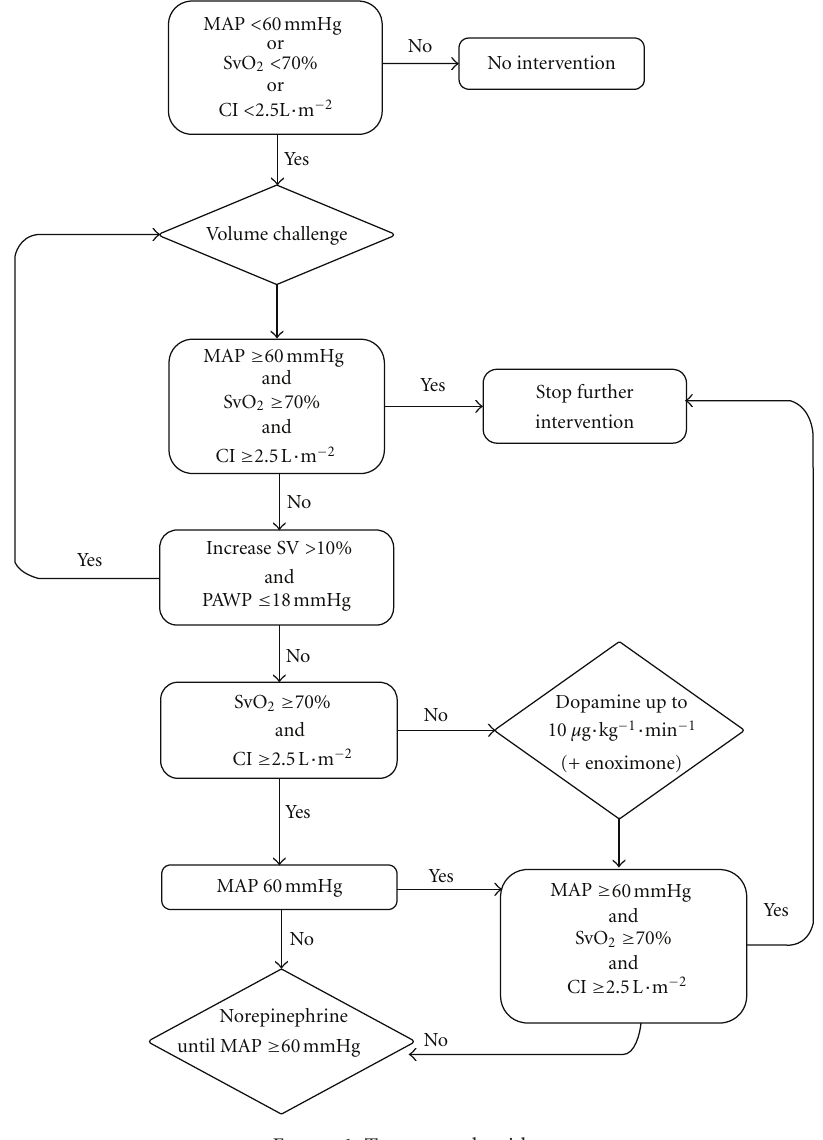
Figure 1: Treatment